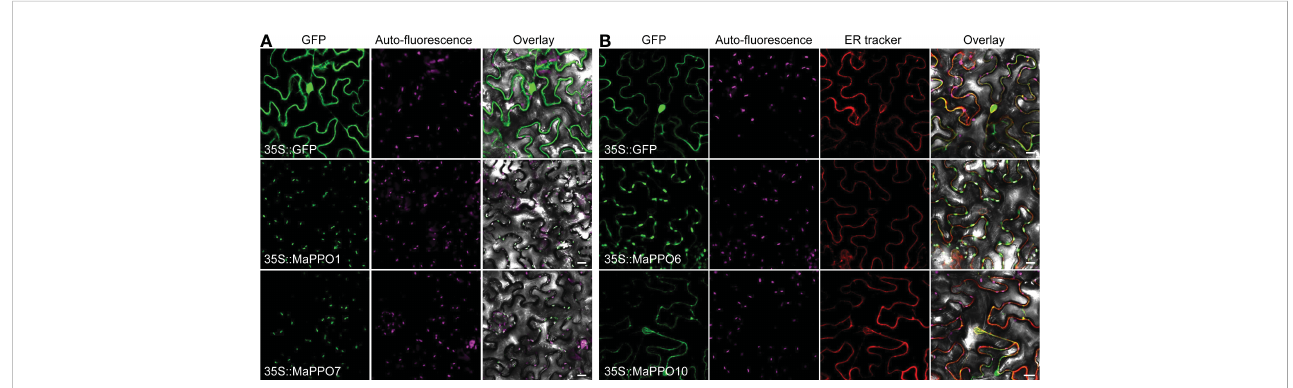
FIGURE 7 Subcellular localization of selected MaPPO proteins in transient tobacco leaves. (A) Subcellular localization of MaPPO1 and MaPPO7; (B) Subcellular localization MaPPO6 and MaPPO10. The GV3101 strains containing corresponding GFP-fused plasmids or endoplasmic reticulum (ER)-mCherry were in fi ltrated into Nicotiana benthamiana leaves. Fluorescence signals were examined using a confocal laser scanning microscope. Bar = 50 m